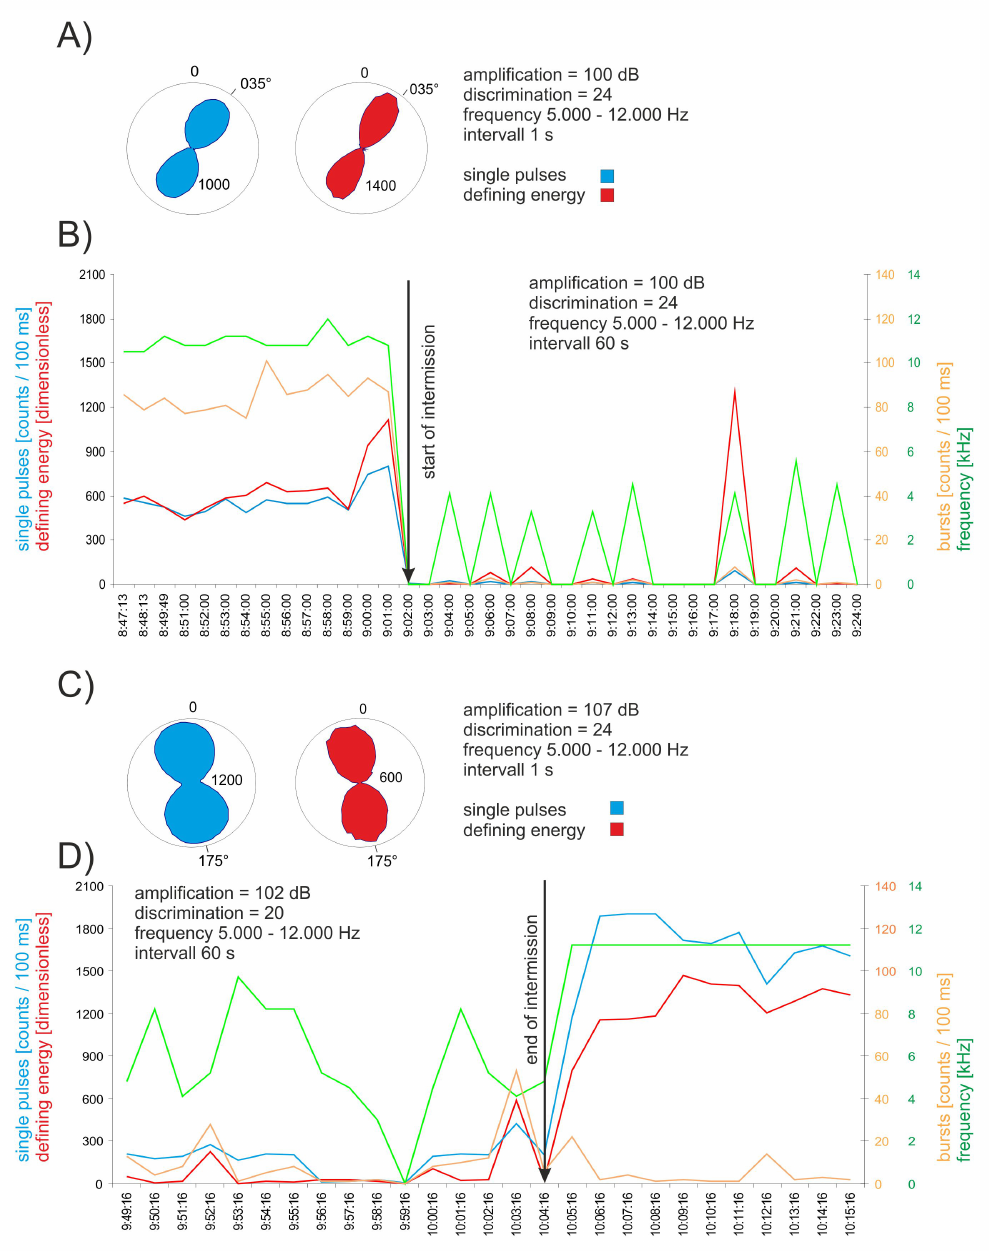
Fig. 7. Results of Cerescope measurements on 15 July 2009 near G¨ottingen (Germany) showing the effects of the daily intermission in the regular broadcasting of DHO38. (A) Horizontal measurement results before the intermission. (B) Time-triggered measurement during the turn off of DHO38 with the antenna oriented horizontally pointing towards 45 ◦ . (C) Results of a horizontal measurement during the intermission. (D) Time-triggered measurement during the turn on of DHO38 with the antenna oriented horizontally pointing towards 45 ◦ .